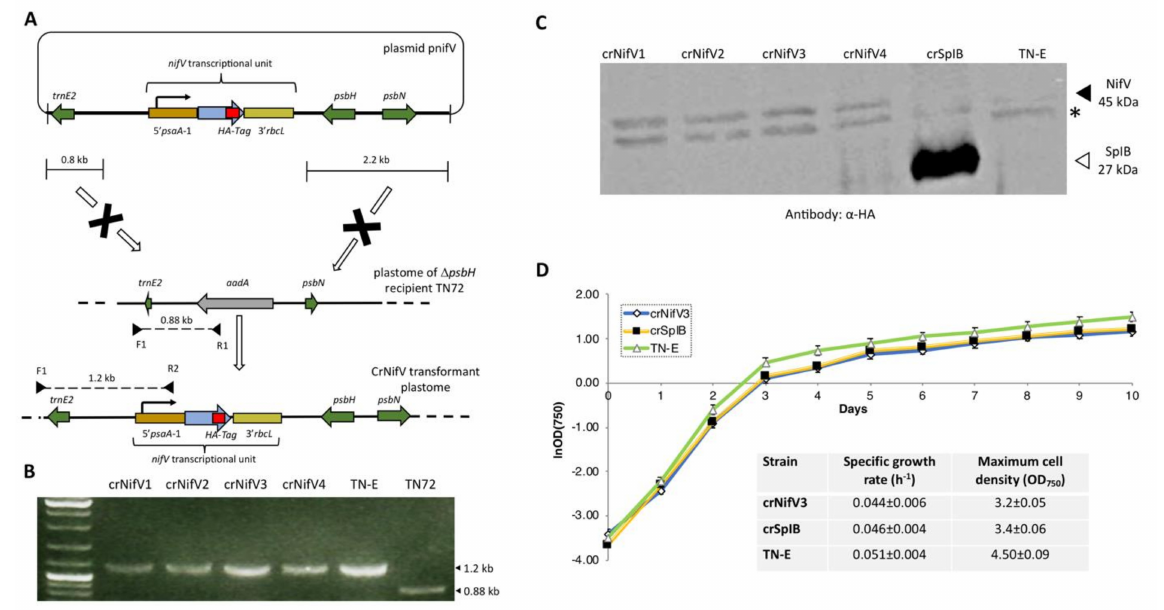
Figure 4. Cloning and expression of nifV from the plastome of C. reinhardtii . ( A ) Insertion of the coding sequence into the chloroplast genome was performed using a methodology described previously [71,72]. The transcriptional unit consisted of the psaA -1 promoter/5 (cid:48) UTR, the nifV gene, and the rbcL 3 (cid:48) UTR. Both the cassette and the functional version of the psbH gene were flanked by sequences needed for homologous recombination, which allowed rescue of the ∆ psbH recipient strain TN72. In this strain the psbH gene has been replaced with an aadA antibiotic-resistance cassette. After transformation, the expression cassette is integrated into an intergenic locus downstream of psbH . ( B ) Colony PCR and agarose gel analysis confirmed the incorporation of the nifV transcriptional unit in four transformant lines. The strain TN72 was used as a negative control, while a strain (TN-E) generated using an “empty” vector was utilised as a positive control. The F1 primer is targeted to the 5 (cid:48) region upstream of the homologous recombination site, whereas the reverse primers are targeted either to the aadA cassette or the nifV transcriptional unit. The 1.2 kb band confirms the insertion of the expression cassette gene into the plastome, while the 0.88 kb band corresponds to the plastome of TN72. The absence of such a band in the transgenic lines indicates that the polyploid plastome is homoplasmic. ( C ) Western blot analysis shows the accumulation of NifV. Cell extracts of four transformant lines (crNifV1-4) were analysed using α -HA epitope tag antibodies as described [70]. Negative (TN-E) and positive (crSpIB) control transformants were included in the analysis. As a loading control, antibodies against the endogenous RbcL were used. (*) denotes the presence of an unknown endogenous protein detected by the α -HA antibodies. ( D ) Expression of recombinant NifV did not have major effects on culture growth. The graph shows growth curves for the crNifV3, crSpIB, and TN-E transformants. For calculating specific growth rate and maximum cell density, cells were grown in 1 L flasks at 120 rpm of agitation and at 50 µ E m − 2 s − 1 . Specific growth rates at stationary phase are an average from three independent